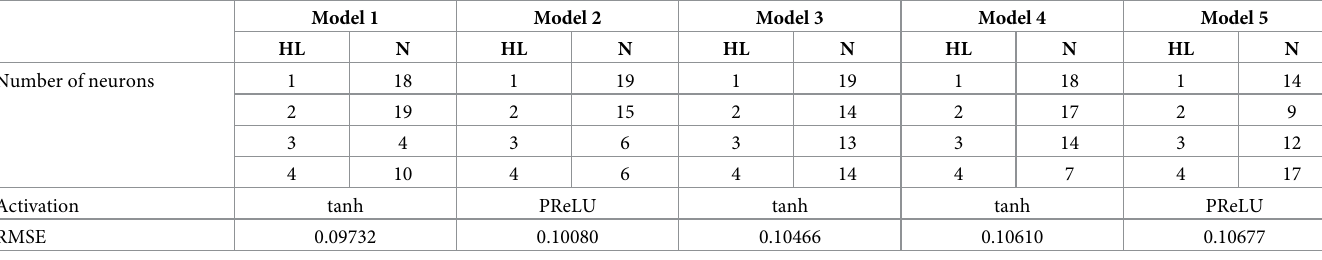
Table 11. Hyperparameter search results summary (Run 4). Top 5 Models out of 250 candidate models from Run 4.